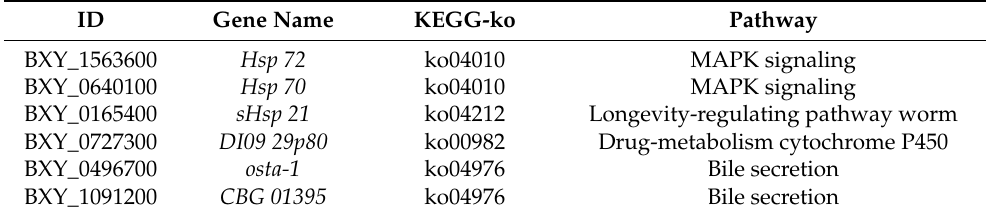
Figure 5. Differential gene expression analysis. CK: the transcriptome of AMA3; T1: the transcriptome of AMA3 processed by GD1; and T2: the transcriptome of AMA3 processed by GD2. ( A ) The comparison of CK and T1. ( B ) The comparison of CK and T2. The blue circles represent down-regulated genes, and the red squares represent up-regulated genes, respectively. ( C ) The result of top 6 genes expression count in RNA-seq. ( D ) The result of relative expression of q-PCR. * p < 0.05, ** p < 0.01 and *** p < 0.001. Table 5. Relative pathways of 6 di ff erentially expressed genes.